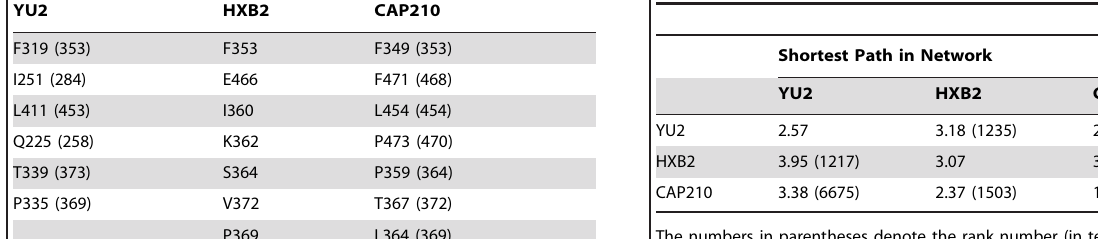
Table 2. The path distance of the shortest path in a particular network is shown for all three